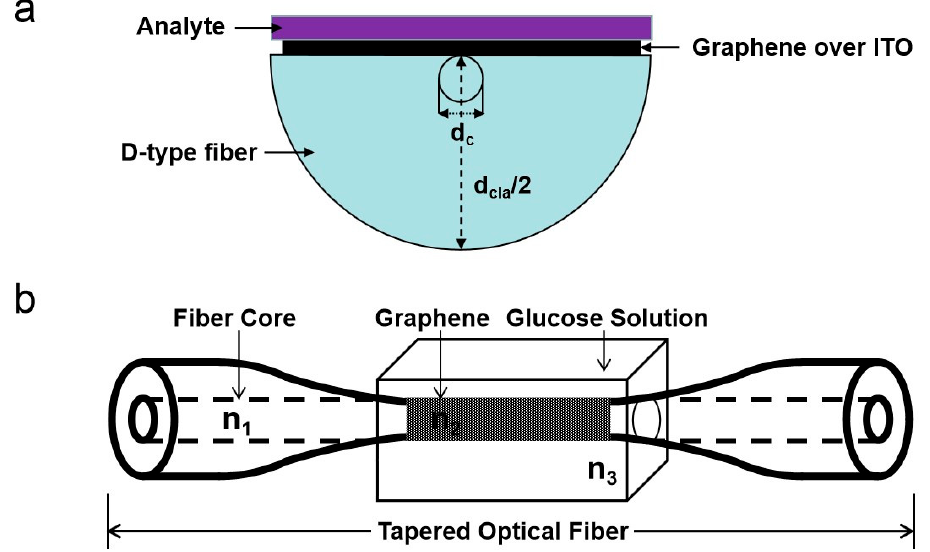
Figure 4. ( a ) Cross-sectional view of the proposed structure. ( b ) The structure of the tapered optical fiber. Graphene is coated on the core of the fiber. fiber. Graphene is coated on the core of the